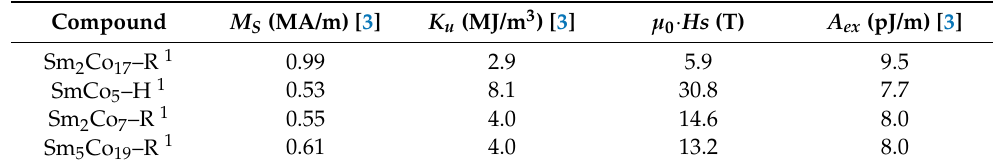
Table 1. Magnetic properties of constituent phases: Saturation magnetization ( M S ), uniaxial anisot- ropy constant ( K u ), and magnetic saturation field ( μ 0 ∙ H s ).